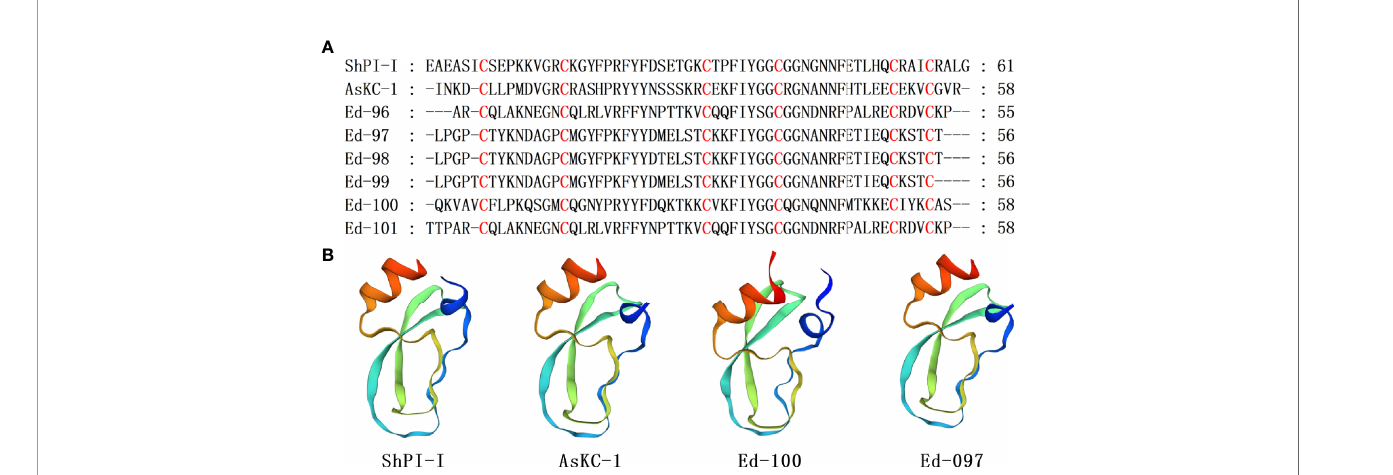
FIGURE 6 | Representative sea anemone mature peptide sequences with Kunitz-type peptides. (A) Alignment of sea anemone mature peptides with Kunitz-type peptides. Cysteines are highlighted in red; (B) Homology modeling prediction of the representative sea anemone mature peptide AsKC-1,Ed-100 and Ed-097 with ShPI-I ( p -stichotoxin-She2a; PDB 3OFW).